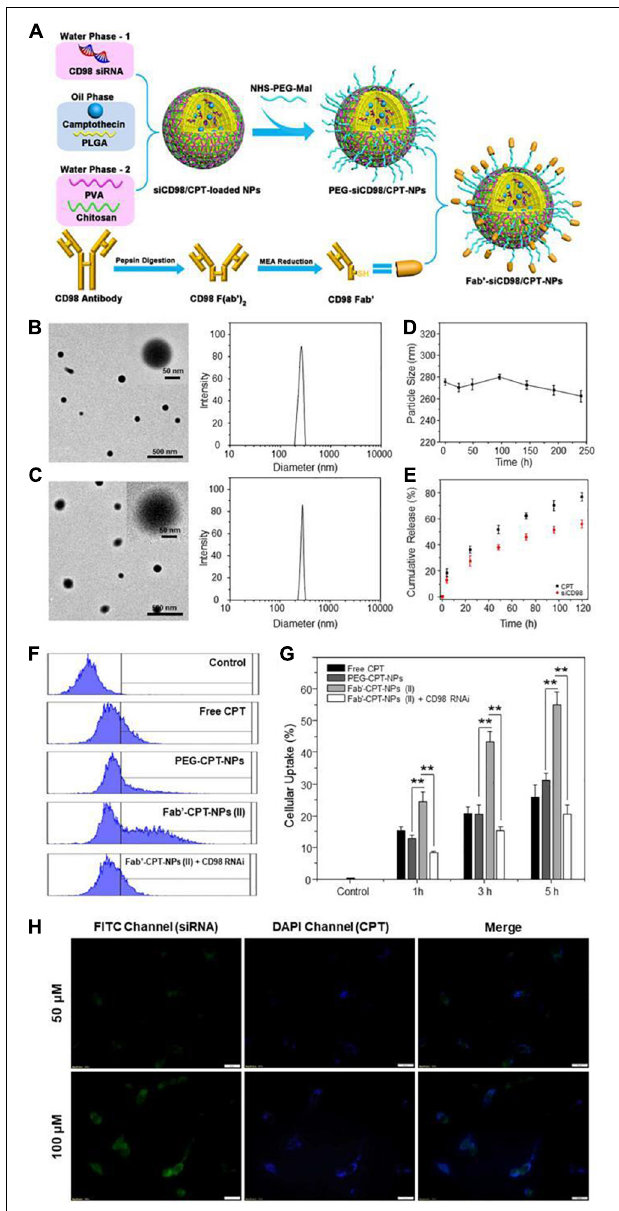
FIGURE 8 | Fabrication, physicochemical characterization and in vitro targeting capacity of Fab’-functionalized nanoparticles (Elsabahy and Wooley, 2012). (A) A schematic illustration of preparation of Fab’-siCD98/CPT-NPs. Initially, Fab’-SH was generated from CD98 antibodies. Then MAL-siCD98/CPT-NPs were yielded by coating siCD98/CPT-NPs with MAL-PEG-NHS. Finally, MAL-siCD98/CPT-NPs were reacted with Fab’-SH to obtain II. (B,C) Representative transmission electron microscope images and size distribution of I and II, respectively. (D) The average particle size of II in deionized water after 240 h of storage at room temperature. (E) In vitro drug release profiles of siCD98 and CPT from II at 37 ◦ C. (F) Representative FCM histograms of fluorescence intensity of cells that were treated with I and II with same CPT concentration (32 µ M) for 5 h. (G) Proportion of CPT-containing cells after being treated 1, 3, or 5 h as (F) . (H) Fluorescence microscopy images of Fab’-FITC-siRNA/CPT-NPs cellular uptake profiles in Colon-26 cells after 5 h treatment, with a scale bar of 20 µ m. Note: (I)PEG-siCD98/CPT-NPs,